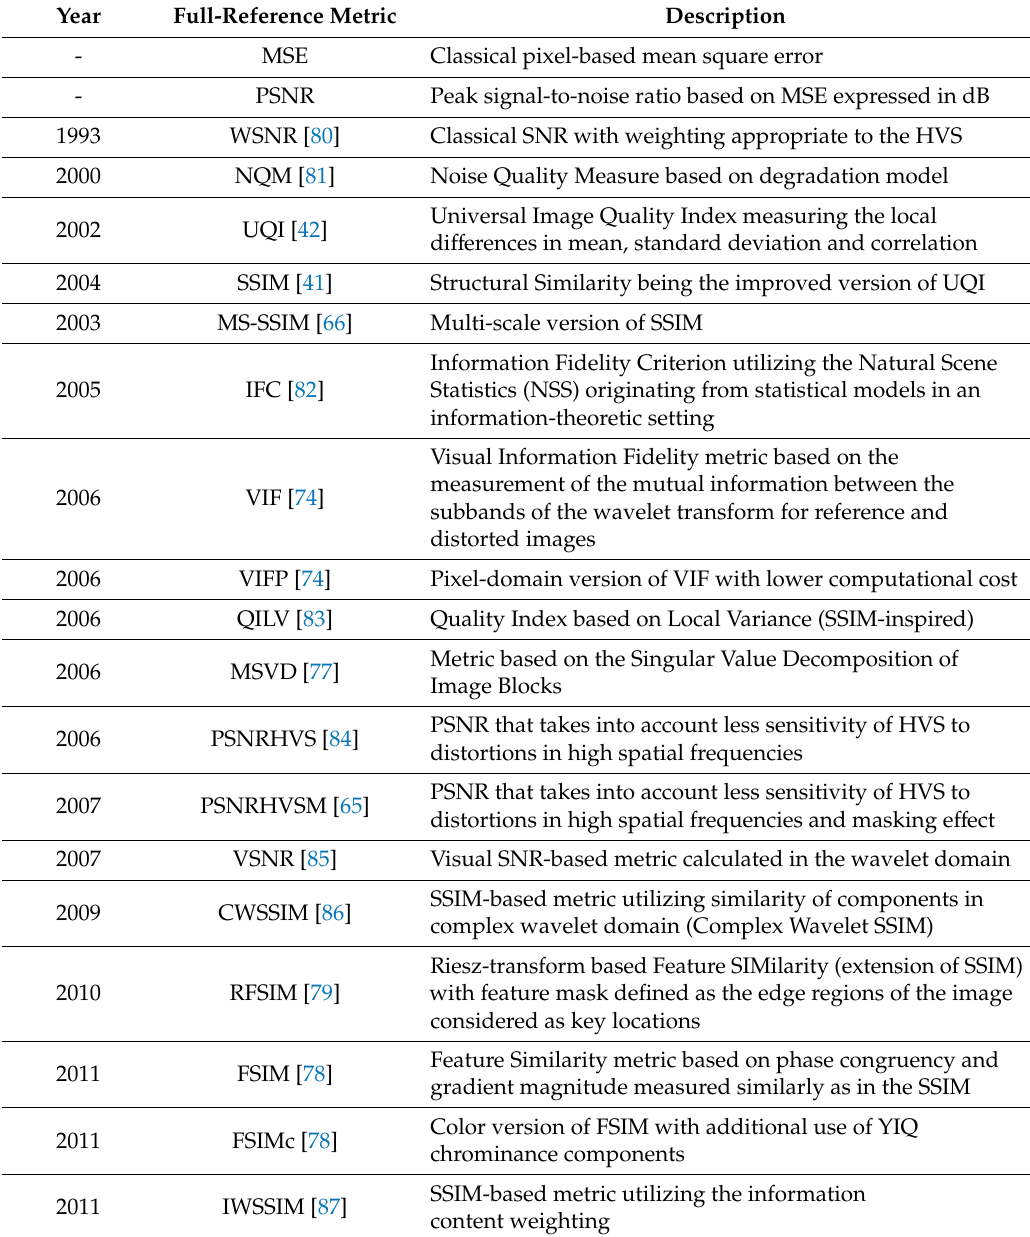
Table 1. Brief descriptions of the elementary metrics used in